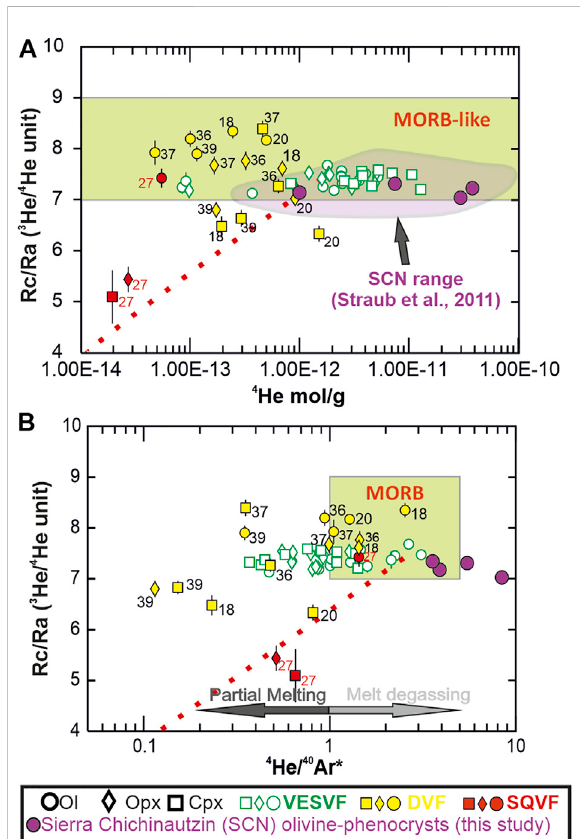
FIGURE 4 (A) 4 He and (B) 4 He/ 40 Ar* vs. 3 He/ 4 He ratios corrected for atmospheric contamination (Rc/Ra). MORB range is reported at Rc/Ra = 8 ± 1 (Graham, 2002) and 4 He/ 40 Ar* from 1 to